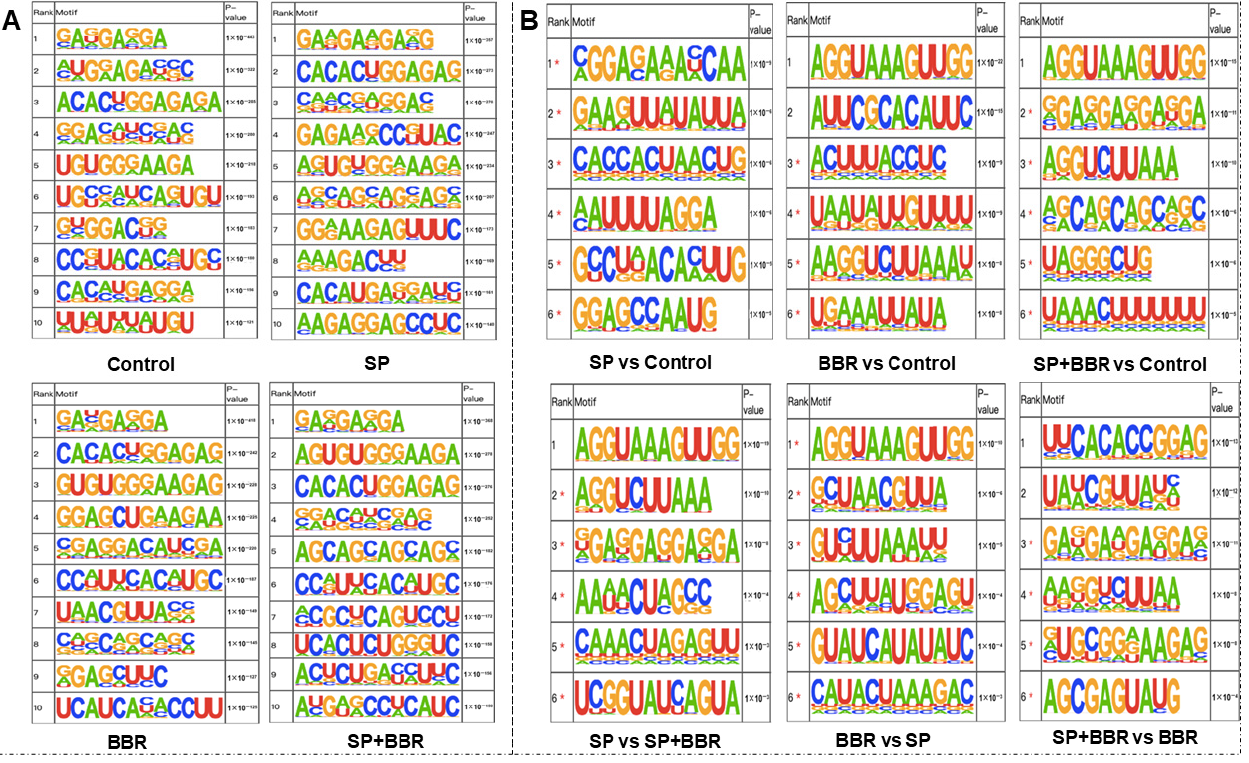
Figure 4. M 6 A methylation analysis. ( A ) is top ten motif analysis for different treatment groups within ZFL. ( B ) is top six motif analysis of each comparison group. *—possible false positive